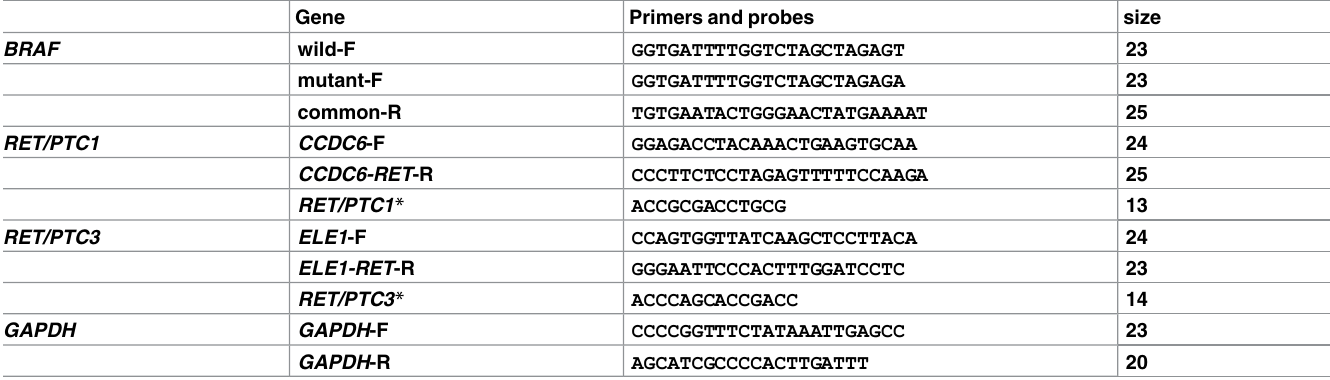
Table 1. The primers or probes for BRAF , RET/PTC1 and RET/PTC3 .